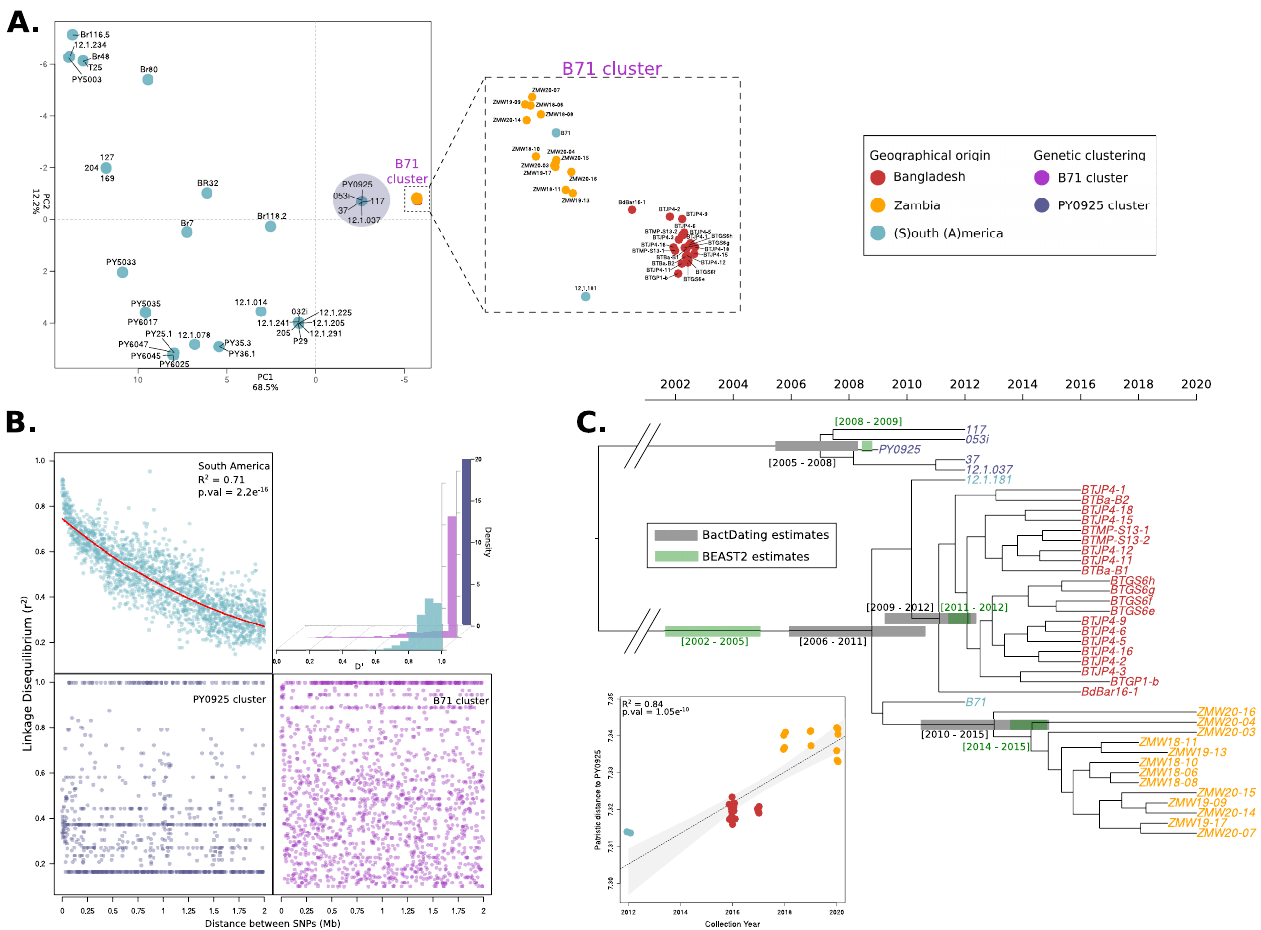
Fig 2. Wheat blast outbreaks in Zambia and Bangladesh originated by independent introductions of the recently emerged B71 clonal lineage. (A) The B71 lineage shows reduced genetic diversity in comparison with South American wheat-infecting isolates. PCA was performed based on genome-wide pairwise Hamming distances of 71 isolates from South America, Asia, and Africa. The colors of the points indicate the provenance of each isolate (see inset). The circular shaded area indicates isolates from the Brazilian cluster (PY0925) that is the closest to the B71 cluster. Axes labels indicate the percentage of total variation explained by each PC. The magnified area shows isolates that are part of the B71 lineage. (B) The B71 cluster is a clonal lineage. The scatter plots show pairwise LD (measured as r 2 ) between SNPs that are at most two megabases apart. The red solid line in the South American cluster represents a fitted exponential decay model using nonlinear least squares. The histograms display LD expressed as D’ for genome-wide SNPs. The points and bars are colored as indicated in the inset. (C) The B71 clonal lineage has recently expanded with independent introductions in Zambia and Bangladesh. The scatter plot shows the linear regression (dotted line) of root-to-tip patristic distances (y-axis) versus collection dates (x-axis) for the isolates of the B71 clonal lineage. Maximum likelihood tip-calibrated time tree of the B71 cluster isolates (the PY0925 cluster was used as an outgroup). The horizontal gray and green bars indicate 95% CI for divergence dates (in calendar years) calculated using BacDating and BEAST2, respectively. The points and isolate names are colored as indicated in the inset. The data underlying this figure can be found in https://doi.org/10.5281/zenodo.7590238. CI, confidence interval; LD, linkage disequilibrium; PCA, principal component analysis; SNP, single nucleotide